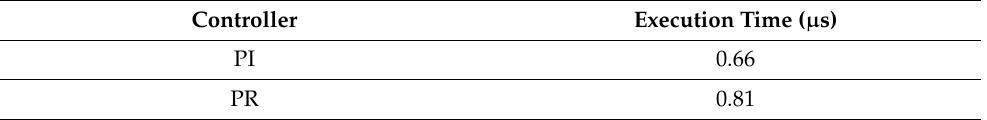
Table 1. Calculation of execution time.